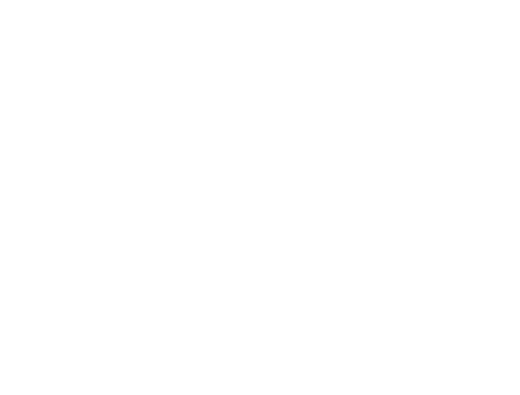
Figure 2. Derma-Hc improves the frequency of scratching behavior in DNCB-induced mice. NOR, Normal saline-treated group; DNCB, 2,4-dinitrochlorobenzene (DNCB)-sensitized group; DEX, DNCB-sensitized and dexamethasone-treated group. The number of scratching was counted for 20 min through watching recorded video. The data are presented as mean ± standard error of the mean. ### p < 0.001 compared to NOR group. *** p < 0.001 compared to individual groups.